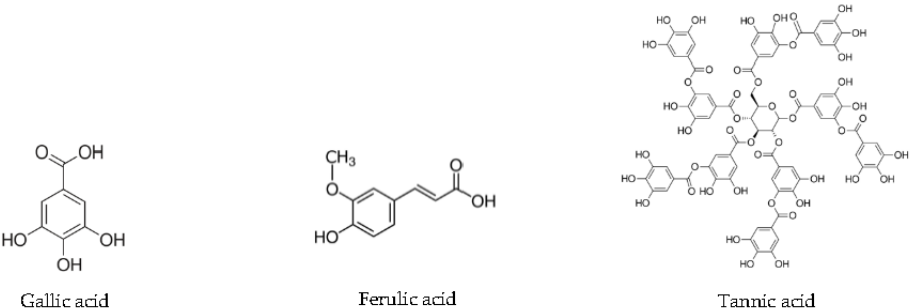
Figure 1. Structures of gallic, ferulic, and tannic acids.